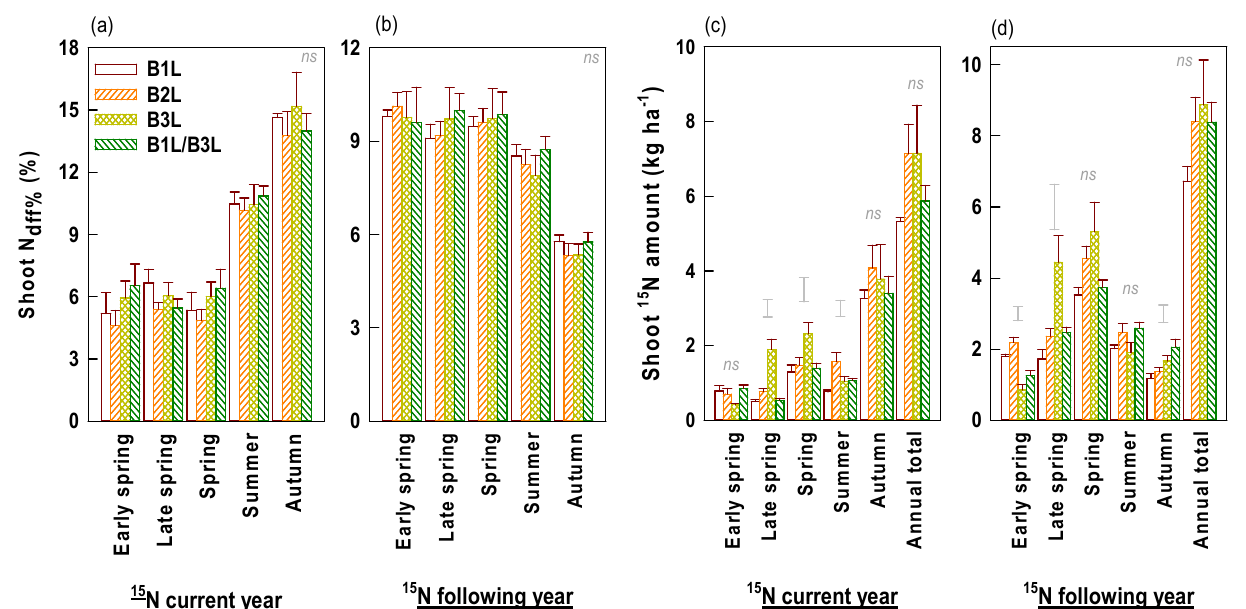
Figure 8. Seasonal N dff% ( a , b ) and 15 N ( c , d ) amounts in young shoots harvested under different stan-